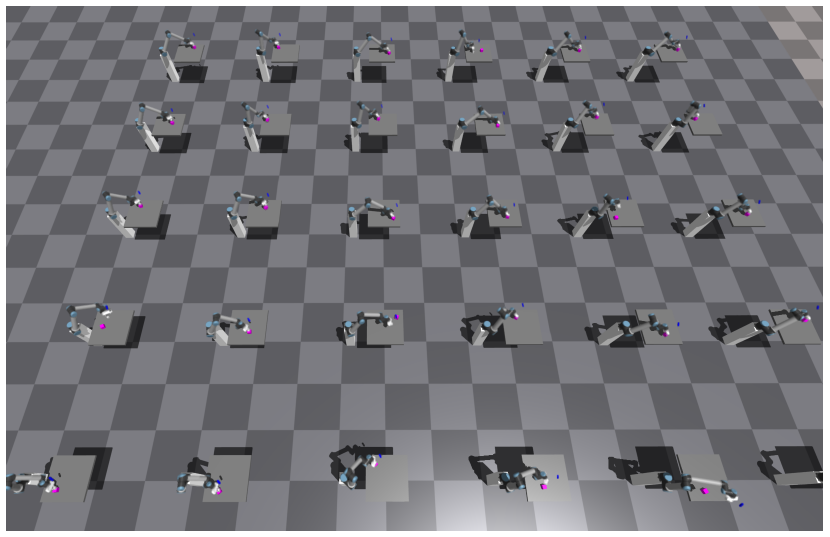
Figure 4. The simulation environment, the number of the sub-environment is depend on the size of GPU Memory.